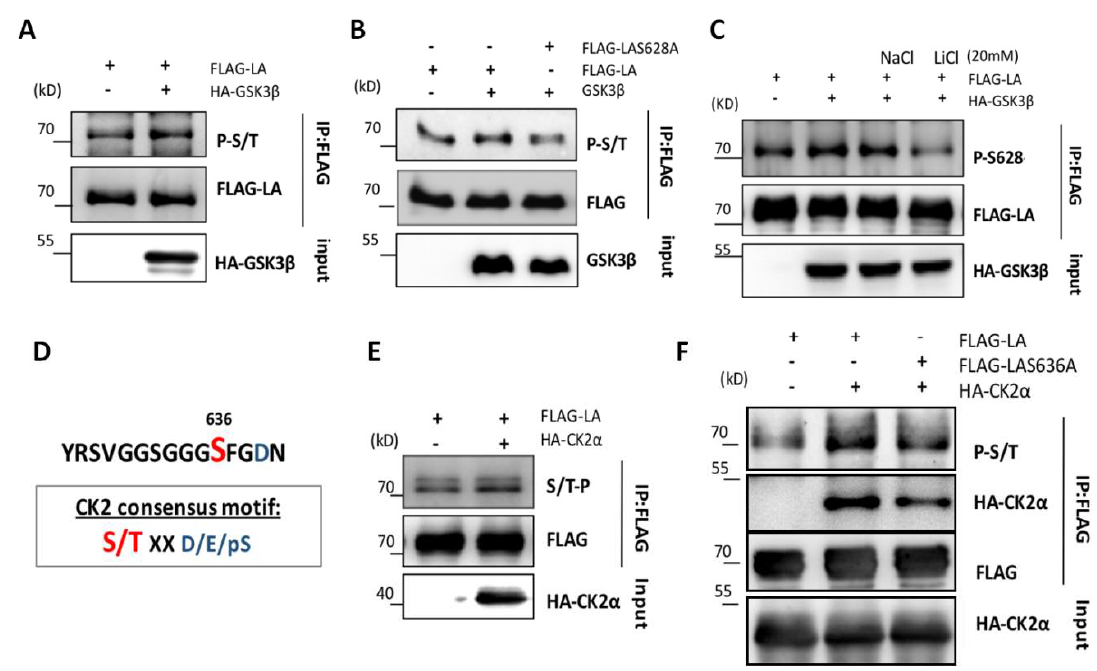
Figure 4. GSK3β-induced phosphorylation of lamin A at Ser628 and CK2α-induced phosphorylation of lamin A at Ser636. ( A ) Immunoprecipitation of FLAG-lamin A and HA-GSK3β expressed in HEK293 cells was performed using FLAG antibodies; phosphorylation levels were detected using a serine/threonine phosphorylation-specific antibody. ( B ) Immunoprecipitation of mutant lamin A (FLAG-LAS628A) and GSK3β expressed in HEK293 cells was performed using FLAG antibodies; phosphorylation levels were detected using a serine/threonine phosphorylation-specific antibody. ( C ) An antibody specific to phosphorylated Ser628 was used to detect lamin A phosphorylation. ( D ) The CK2α consensus motif conforms to the Ser636 site. ( E ) The level of lamin A phosphorylation was detected following FLAG antibody immunoprecipitation from 293T cells co-expressing HA-CK2α and FLAG-lamin A. ( F ) The level of lamin A phosphorylation was detected following FLAG antibody co-immunoprecipitation from 293T cells co-expressing HA-CK2α and mutant lamin A. All transfections were expressed in HEK293